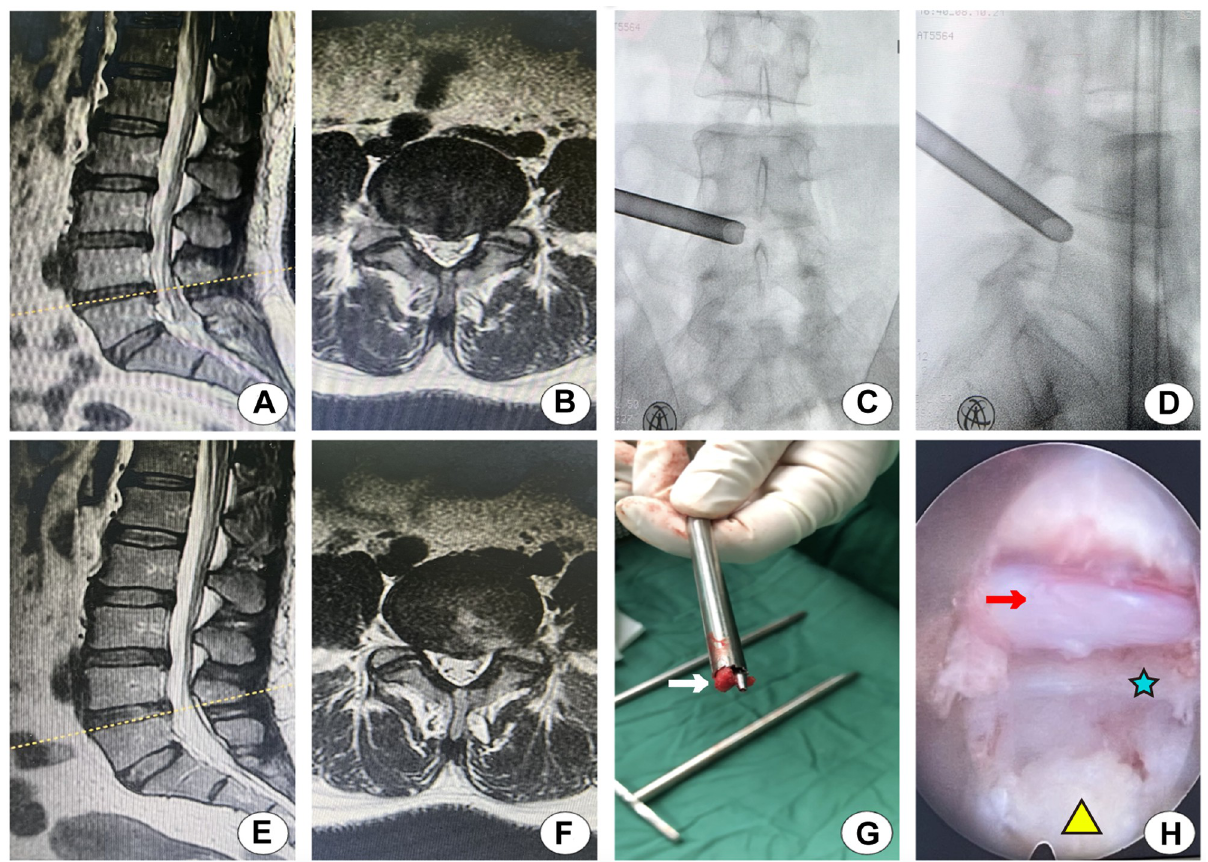
Fig 3. Typical case one. (A, B) Preoperative MRI showed the disc prolapse at the L4-L5 level. (C, D) The anteroposterior and lateral fluoroscopy of the working cannula in foraminoplasty with a single large trephine. (E, F) Postoperative MRI showed the complete removal of the protruded nucleus pulposus. (G) The bone parts of the articular process were removed in foraminoplasty. (H) The nerve roots were fully decompressed during the operation: the red arrow, nerve root; the blue star, the posterior longitudinal ligament; the yellow triangle, the nucleus pulposus.